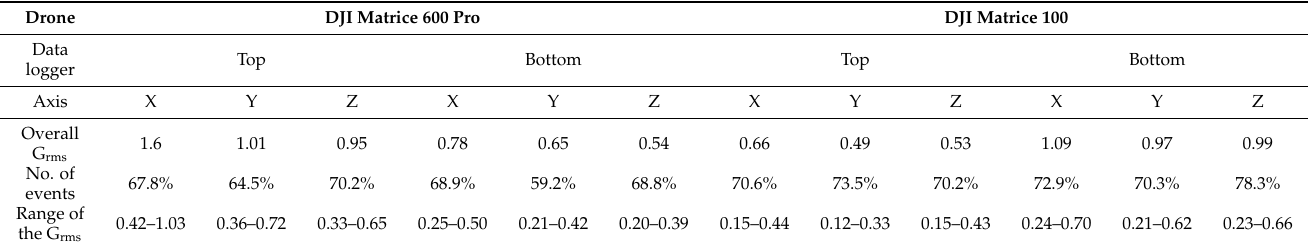
Table 5. Overall vibration G rms value and G rms values near 68%.